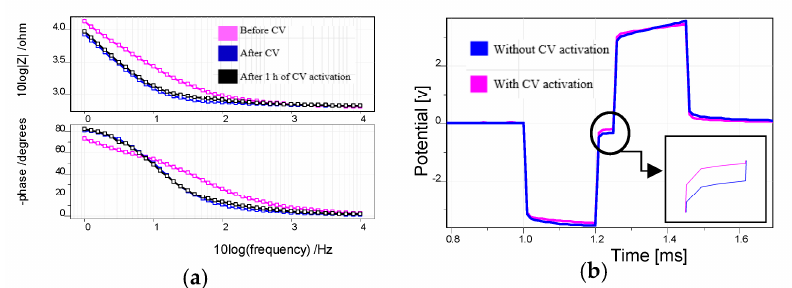
Figure 5. ( a ) Impedance magnitude and phase curve of PEDOT:PSS coated gold electrode before, right after CV activation and 1 h after CV activation; ( b ) electrode polarization after biphasic current pulse for CV activated and non-activated PEDOT:PSS coated electrode; electrode polarization reduced 100 mV (cyclic voltammetry abbreviated as